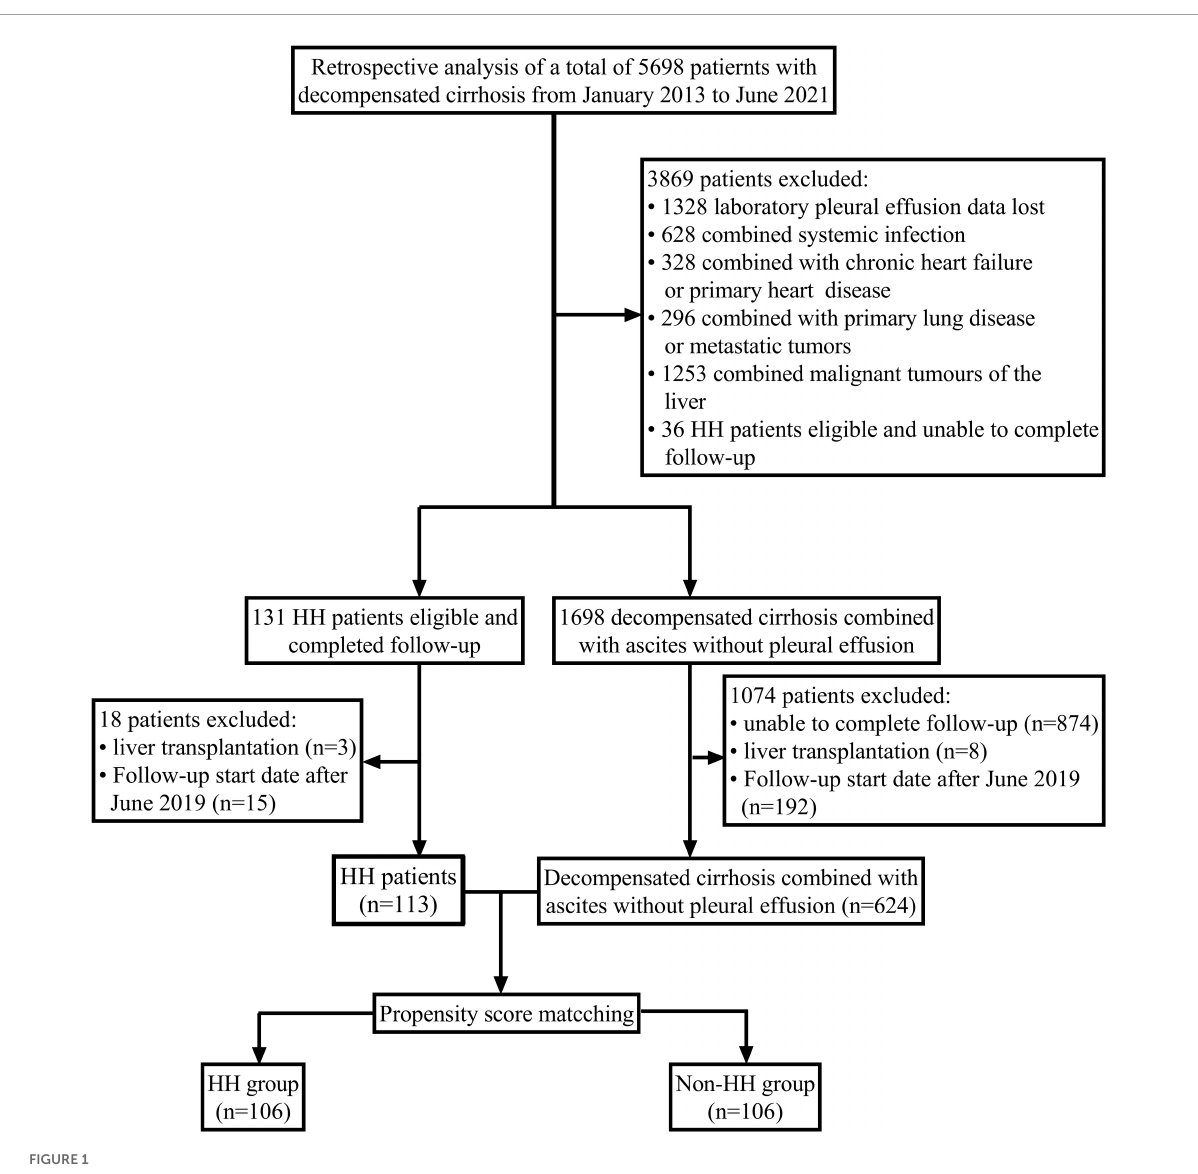
FIGURE1 Study flow diagram. HH, hepatic